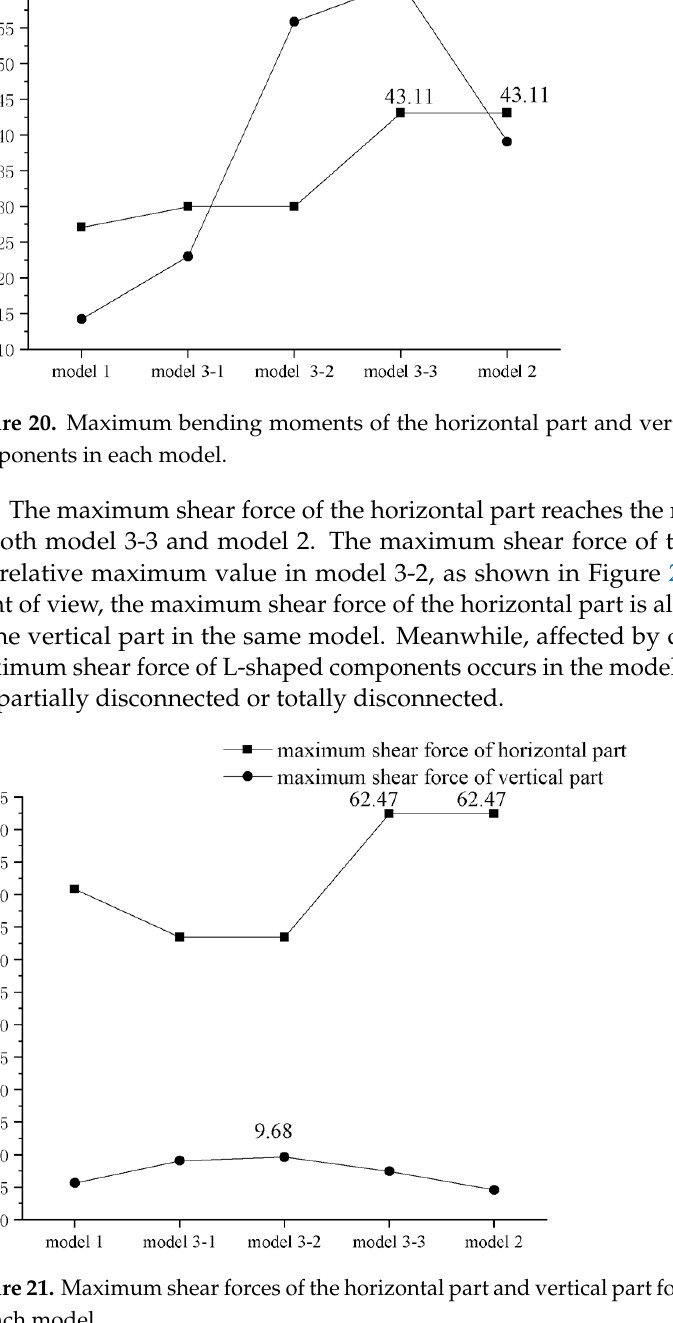
values of the vertical part also remain the same from top to